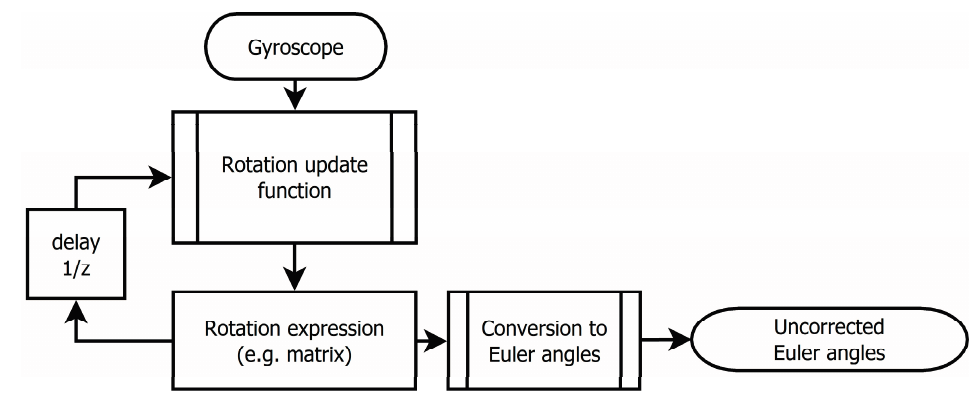
Figure 3. Schematics expressing principle of real-time gyroscope data